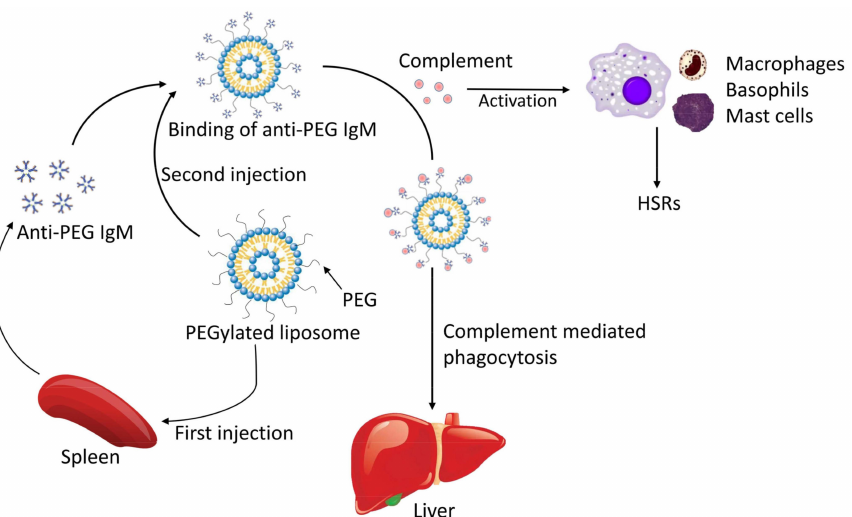
Figure 3. The mechanism of ABC phenomenon and HSRs induced by PEGylated liposomes for its